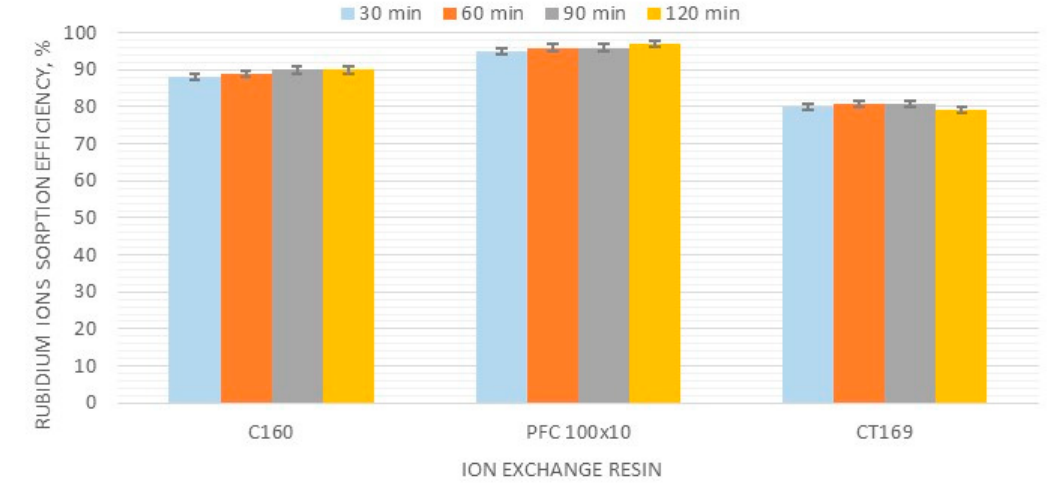
Figure 2. Effect of contact time on the rubidium ion sorption Figure 2 . Effect of contact time on the rubidium ion sorption efficiency.